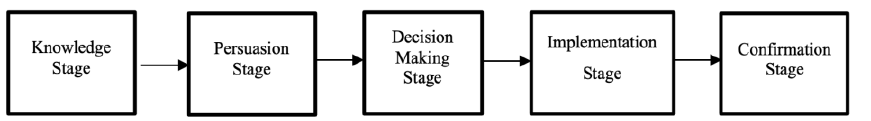
Figure 1. Rogers’ innovation adoption process Figure 1. Rogers ’ innovation adoption process (1983).